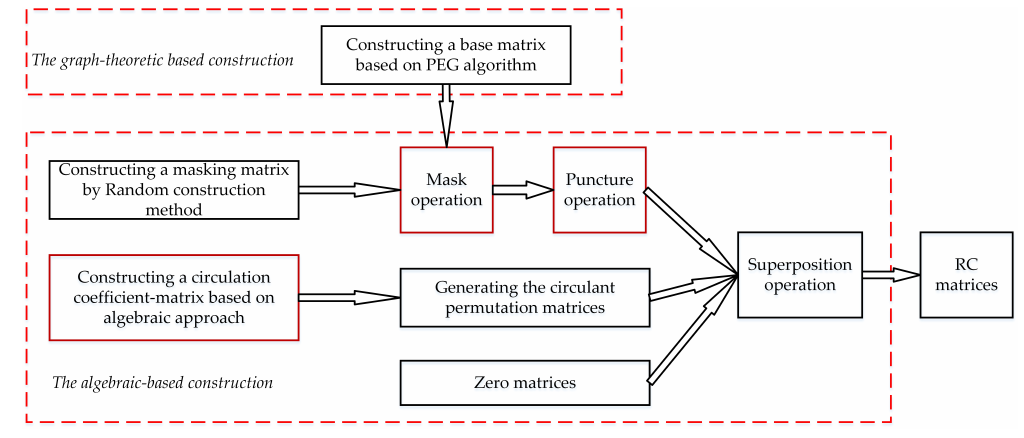
Figure 1. The model considers the original image as a “panda” (57.7%). Indeed, the image added a Figure 1. RC-NB-LDPC codes construction tiny perturbation is classified as a “gibbon” by the same model (99.3%), while the human eyes cannot identify the difference (Image Credit: Goodfellow et al. [15]).